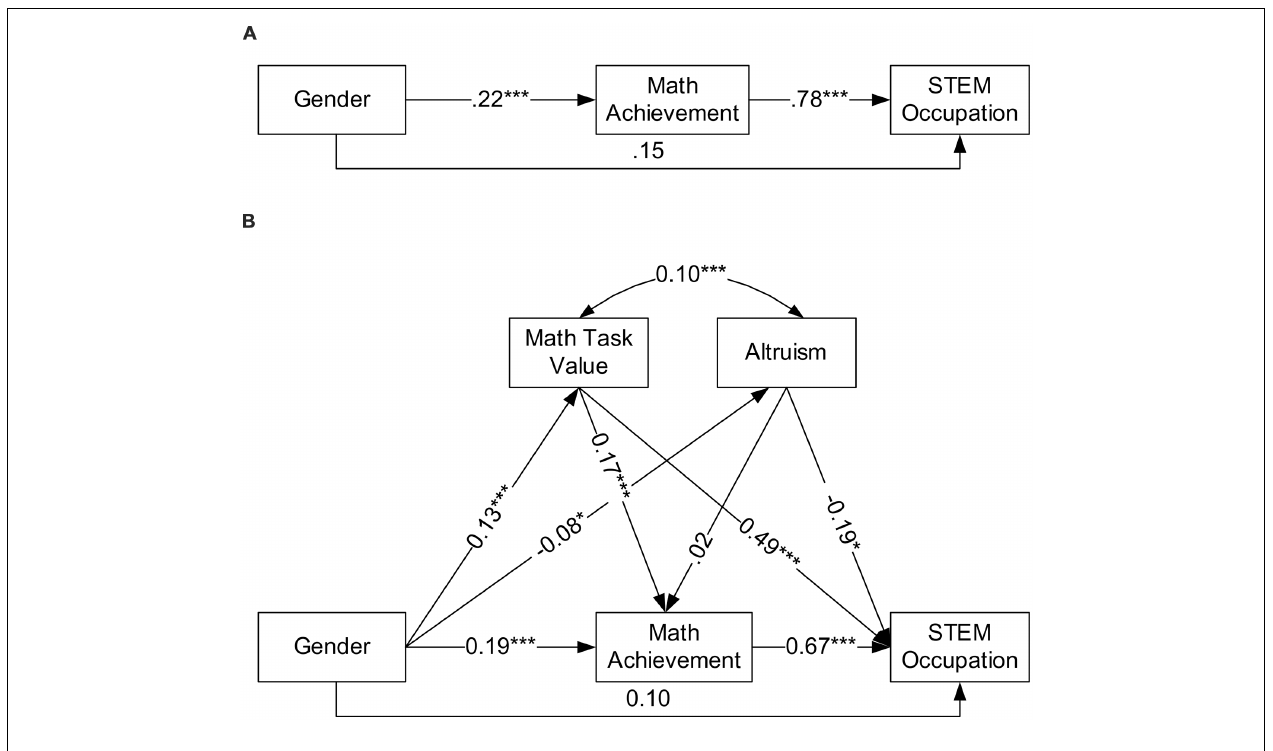
FIGURE 1 | Mediation effects of math task value, altruism, and math achievement on gender difference in STEM occupation. (A) Presents results with math achievement as the only mediator and (B) presents results with math task value and altruism added